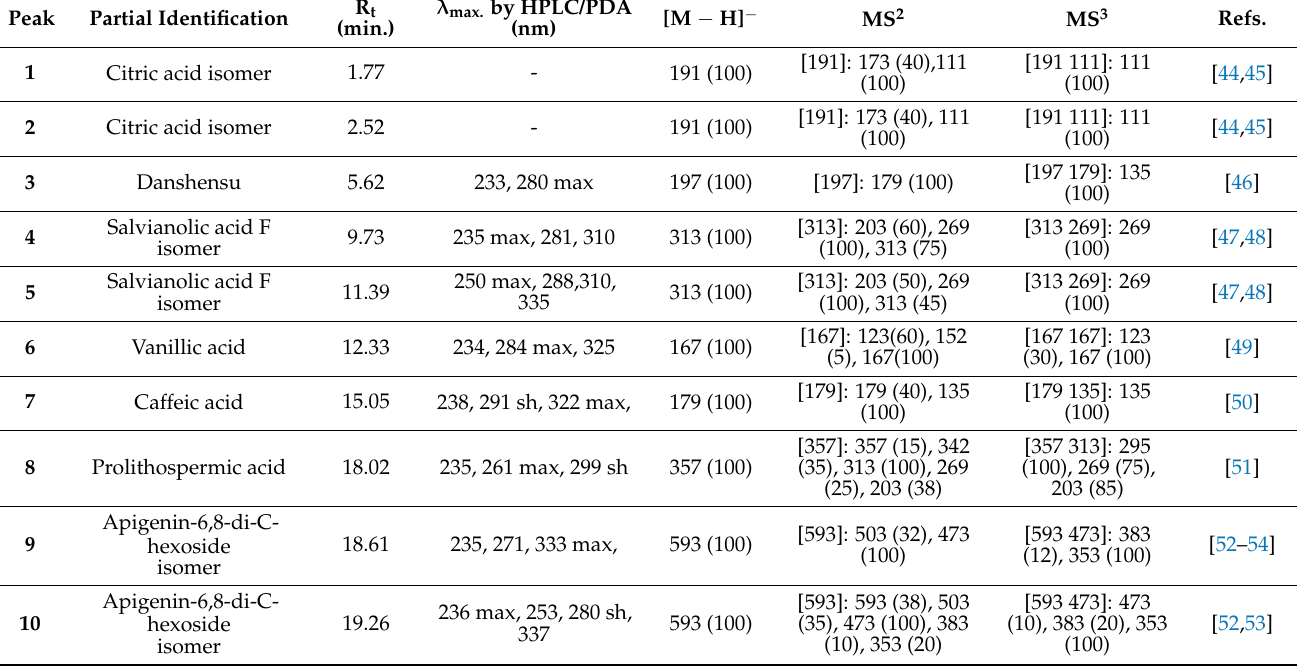
Figure 2. HPLC-PDA-ESI-MSn chromatogram of hydrodistillation residual water from T. capitata , recorded at 320 nm. Table 2. Compounds identified in hydrodistillation residual water from T. capitata by HPLC-PDA-